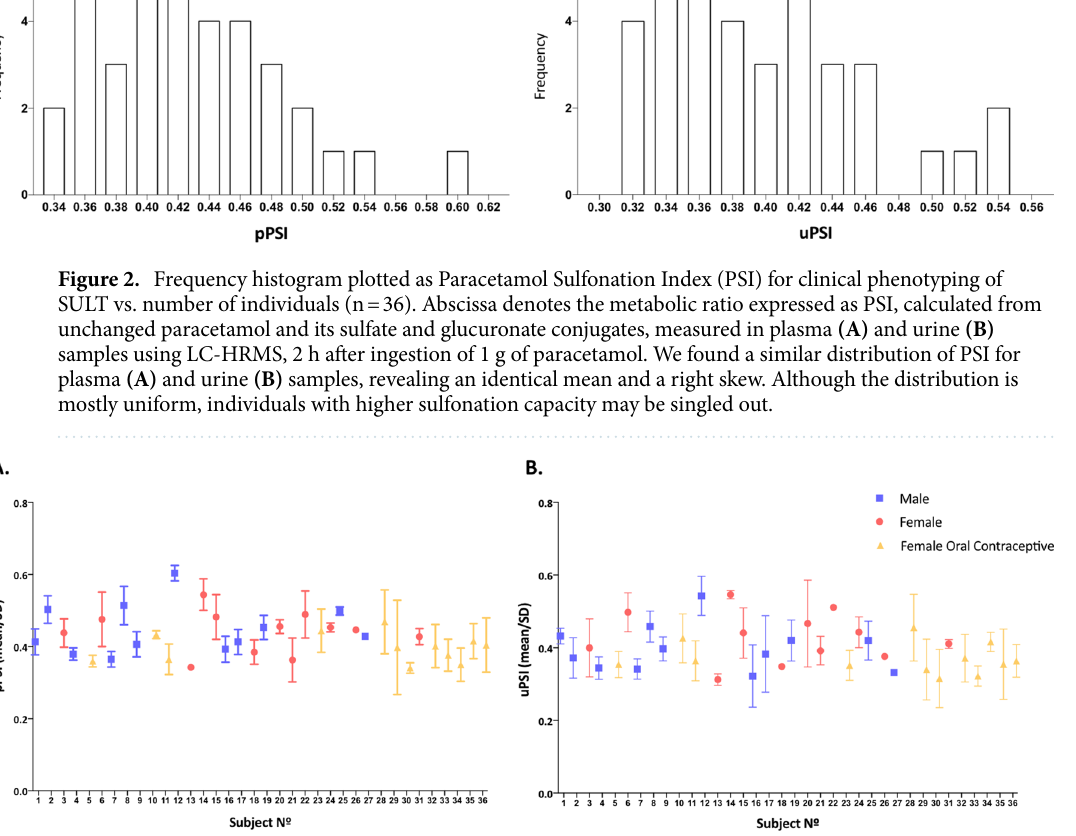
Figure 3. Mean Paracetamol Sulfonation Index (PSI) for clinical phenotyping of SULT in 34 individuals. PSI was calculated from unchanged paracetamol and its sulfate and glucuronate conjugates, measured in plasma (A) and urine (B) samples using LC-HRMS, after ingestion of 1 g of paracetamol on three separate occasions. Data are mean and standard deviation (SD) calculated for every subject; only one value is presented for individuals No. 26 and No. 27, who missed two phenotyping